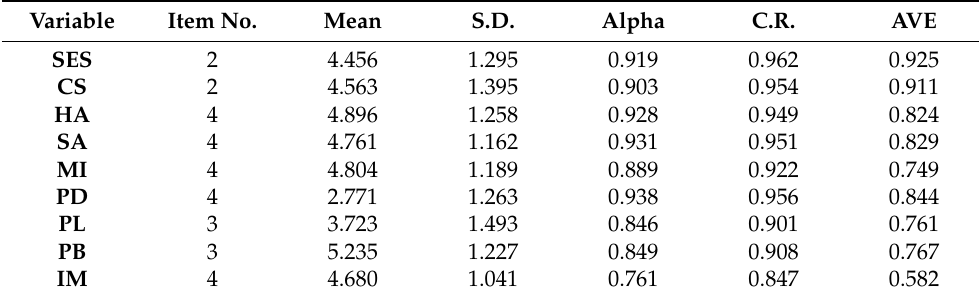
Table 4. Descriptive statistics and reliability.